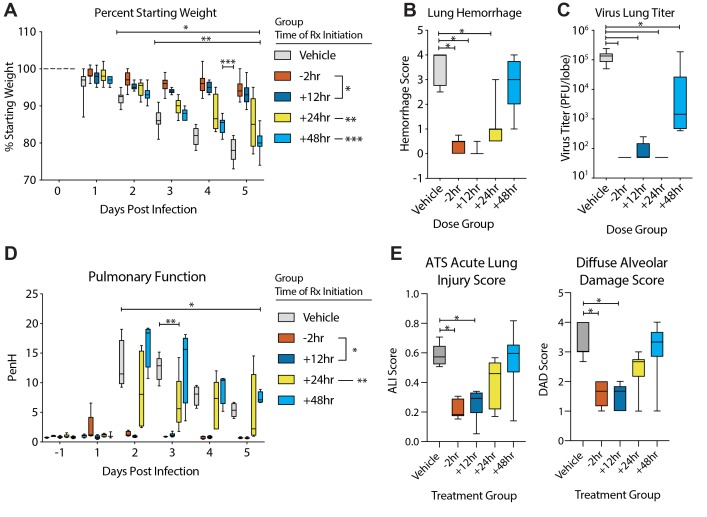
Prophylactic and therapeutic EIDD-2801 reduces SARS-CoV replication and
pathogenesis. Equivalent numbers of 25-29 week old male and female C57BL/6
mice were administered vehicle (10% PEG, 2.5% Cremophor RH40 in water) or NHC prodrug
EIDD-2801 beginning at -2 hours, +12, +24 or +48 hours post infection and every 12
hours thereafter by oral gavage (n = 10/group). Mice were intranasally infected with
1E+04 PFU mouse-adapted SARS-CoV MA15 strain. (A) Percent starting
weight. Asterisks indicate differences from vehicle treated by two-way ANOVA with
Tukey’s multiple comparison test. (B) Lung hemorrhage in mice from
panel A scored on a scale of 0-4 where 0 is a normal pink healthy lung
and 4 is a diffusely discolored dark red lung. (C) Virus lung titer in
mice from panel A as determined by plaque assay. Asterisks in both panel
B and C indicate differences from vehicle by one-way ANOVA
with a Dunnett’s multiple comparison test. (D) Pulmonary function
by whole body plethysmography was performed daily on five animals per group. Asterisks
indicate differences from vehicle by two-way ANOVA with a Dunnett’s multiple
comparison test. (E) The histological features of acute lung injury (ALI)
were blindly scored using the American Thoracic Society Lung Injury Scoring system and
a Diffuse Alveolar Damage Scoring System. Three randomly chosen high power (60X)
fields of diseased lung were assessed per mouse. The numbers of mice scored per group:
Vehicle N = 7, -2 hours N = 9, +12 hours N = 9, +24 hours N = 10, +48 hours N = 9.
Asterisks indicate statistical significance compared to vehicle by Kruskal-Wallis with
a Dunn’s multiple comparison test. For all panels, the boxes encompass the 25th
to 75th percentile, the line is at the median, while the whiskers represent the range.
*, -2 hours and +12 hours compared to vehicle; **, +24 hours compared to vehicle; ***,
+48 hours compared to vehicle.